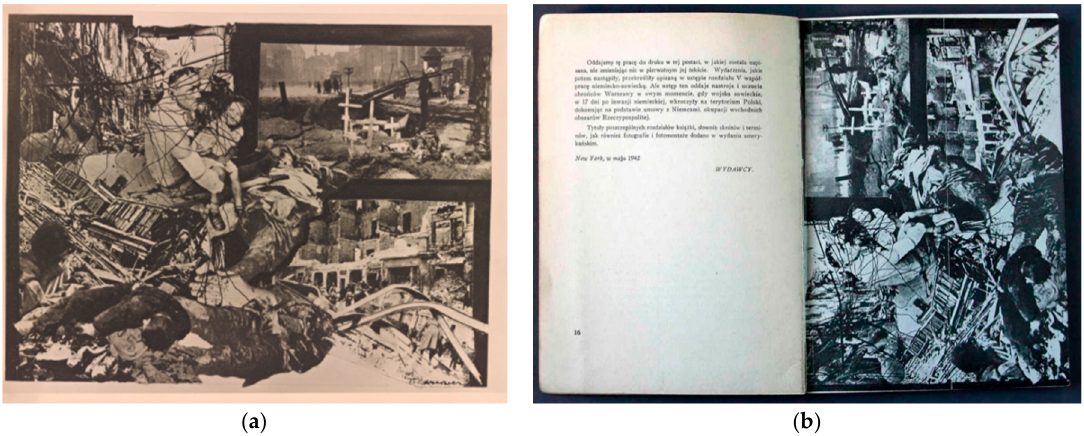
Figure 8. ( a ) Teresa Ż arnower, In the days of terror (2), photomontage from the book Defense of Warsaw , 1942, The New York Public Library, public domain image; ( b ) Teresa Ż arnower, In the days of terror (2), photomontage in the book Defense of Warsaw , 1942, courtesy of On Paper Store, Italy.